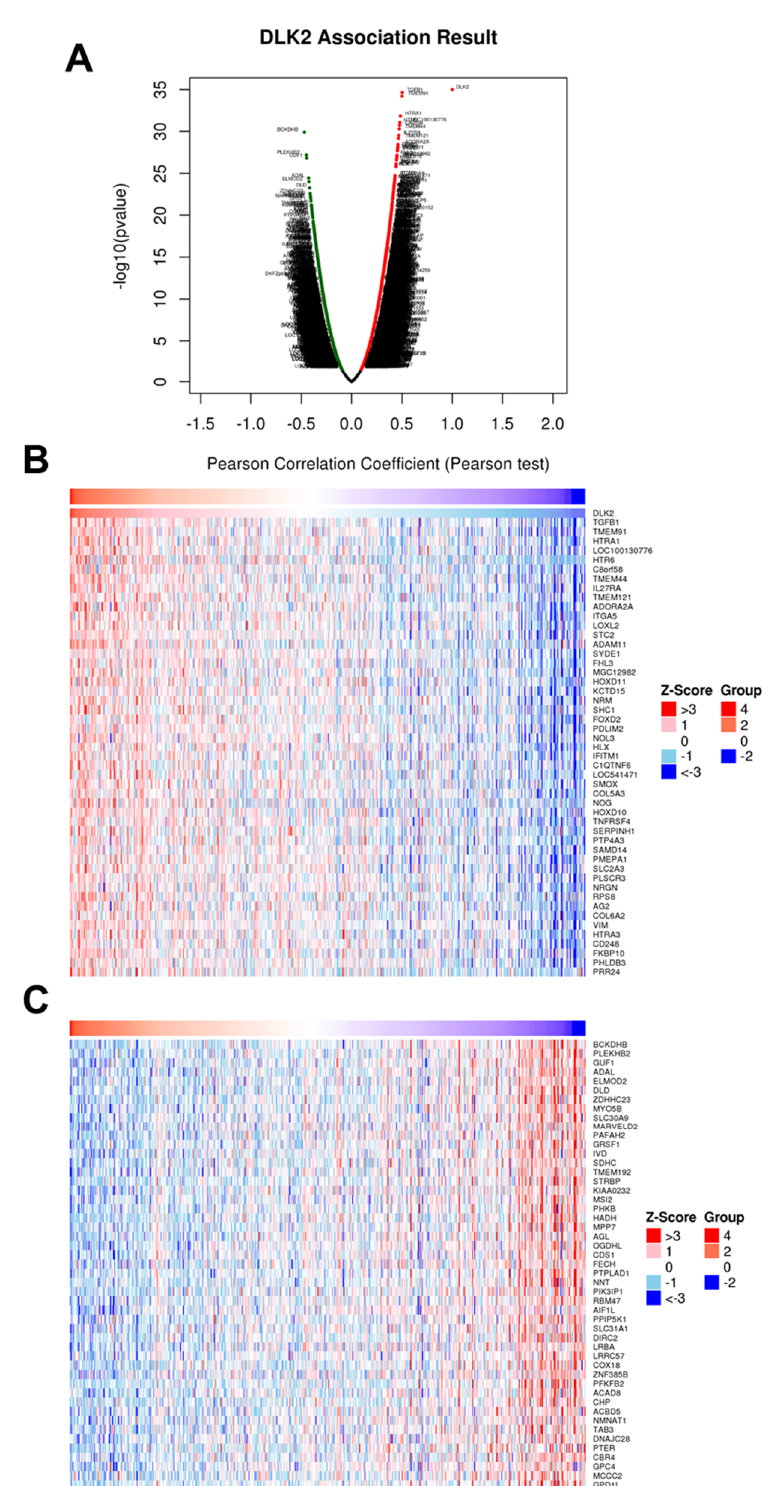
Figure 5. The genes positively and negatively correlated with the DLK2 level in ccRCC are identified using LinkedOmics database. ( A ) The Volcano Plot shows the total genes highly associated with the DLK2 level in ccRCC. Heat maps of the top 50 genes ( B ) positively and ( C ) negatively correlated with DLK2 in ccRCC.